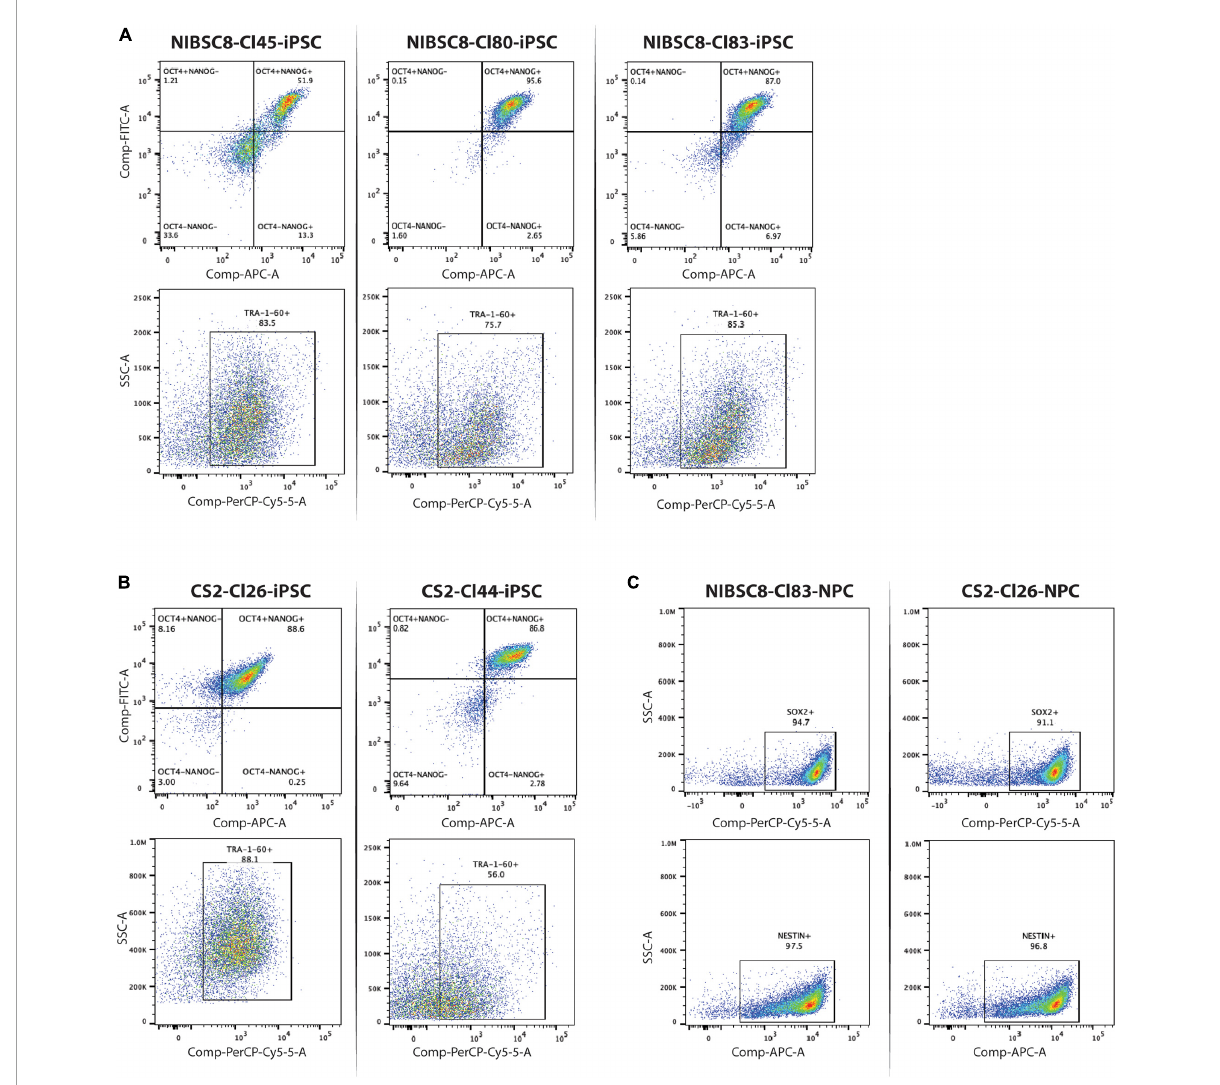
FIGURE2 Expression of stem cell and neuroprogenitor cell markers in selected clones containing sfGFP tag. Flow cytometry charts showing the expression of three hiPSC markers (OCT4, NANOG, TRA1-60) in the selected clones for NIBSC8 (A) and CS2 (B) cell lines. (C) Flow cytometry charts showing expression of neuroprogenitor cell markers (SOX2 and NESTIN) following neural induction of NIBSC8-Cl83 and CS2-Cl26 hiPSCs. Gates for both cell lines and clones were set up based on corresponding single color/unstained controls separately for each line/clone ( Supplementary Figures 7A, B ). SSC-side